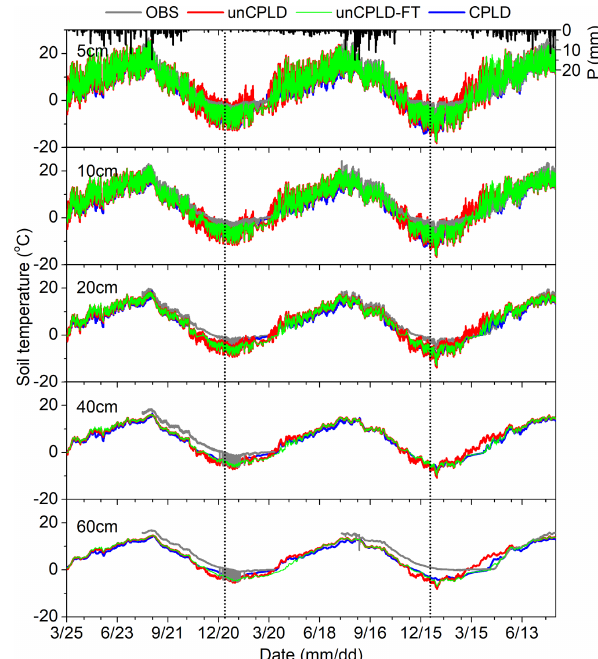
Figure 6. Measured and estimated soil moisture at various soil lay- ers using uncoupled T&C (unCPLD), uncoupled T&C with the FT process (unCPLD-FT), and coupled T&C and STEMMUS (CPLD) models. Note that in unCPLD model, soil ice content is not explic- itly considered, and thus all the water remains in a liquid phase, which leads to a strong overestimation of winter soil water content in frozen soils.